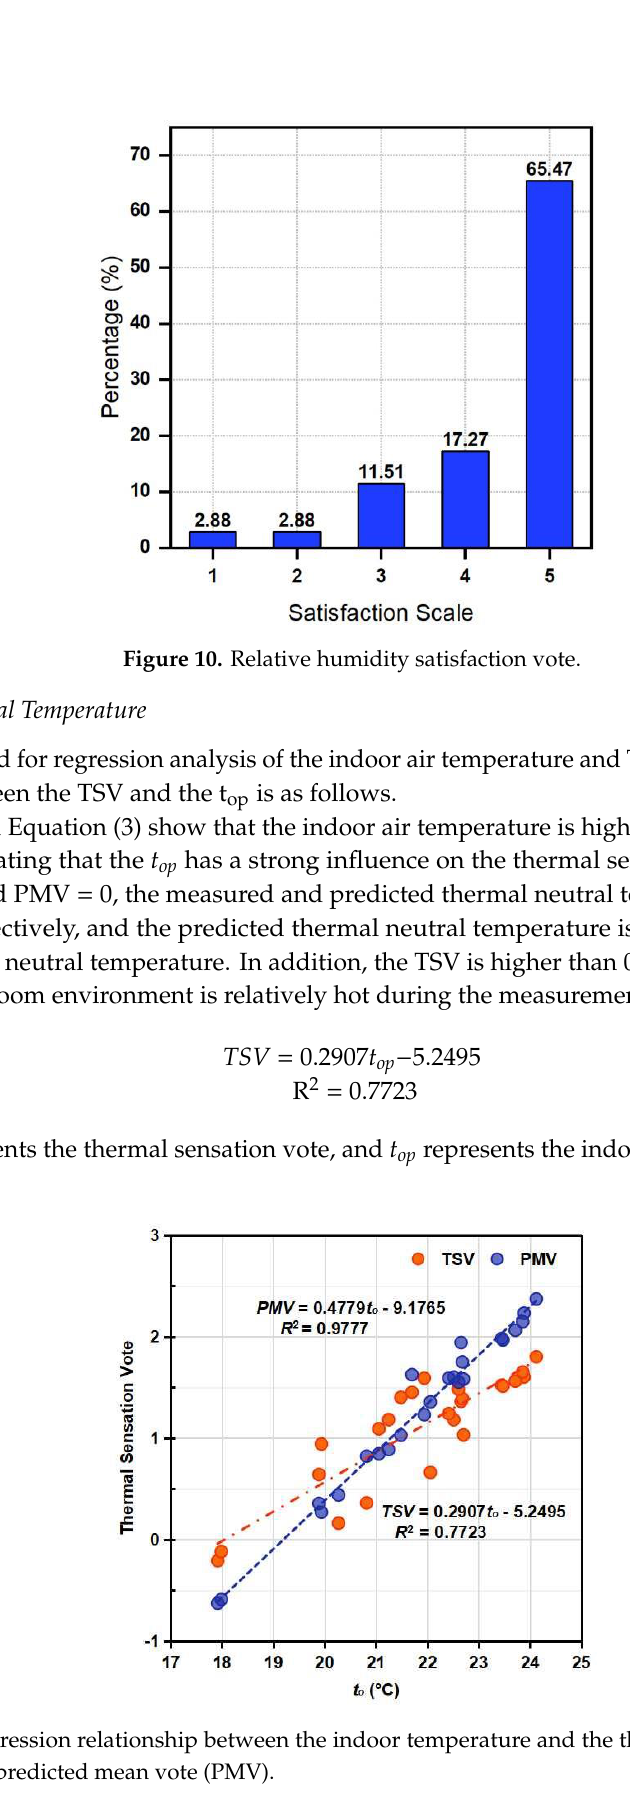
Figure 9. Relative humidity sensation vote.